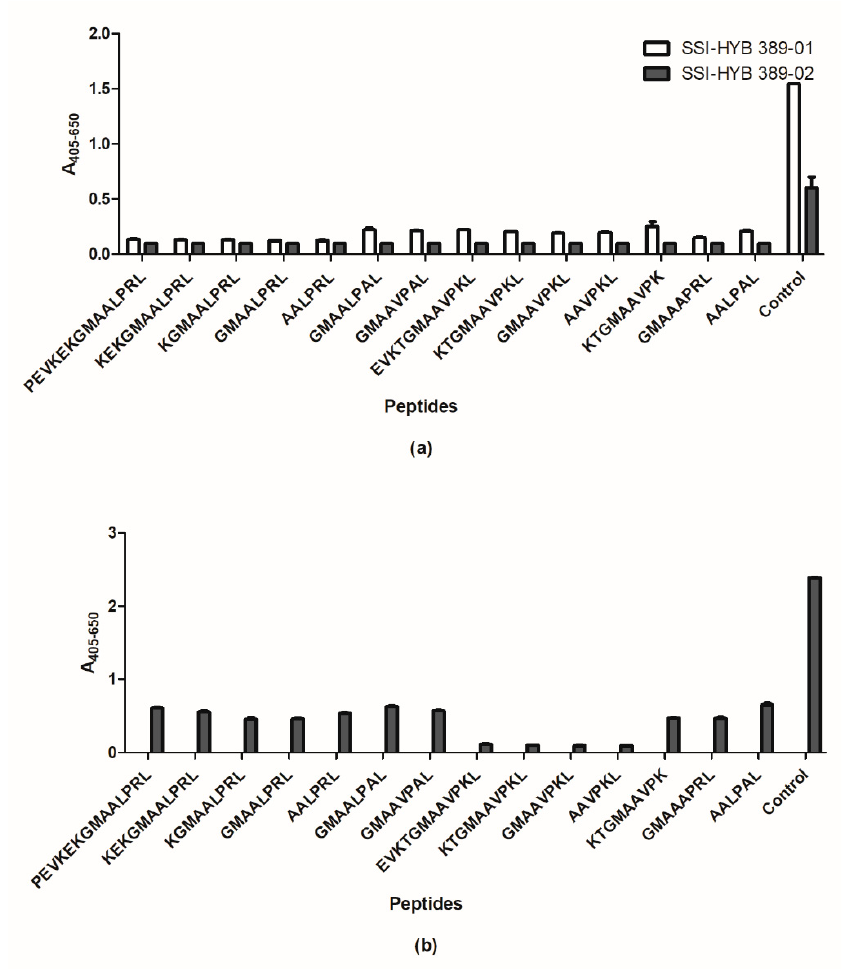
Figure 10. Reactivity of SSI-HYB 387-02 and SSI-HYB 389-01 and -02 to truncated and substituted glutamic acid decarboxylase (GAD) peptides analyzed by competitive inhibition assay. ( a ) Reactivity of SSI-HYB 389-01 and 389-02 to GAD65. ( b ) Reactivity of SSI-HYB 387-02 to GAD67.